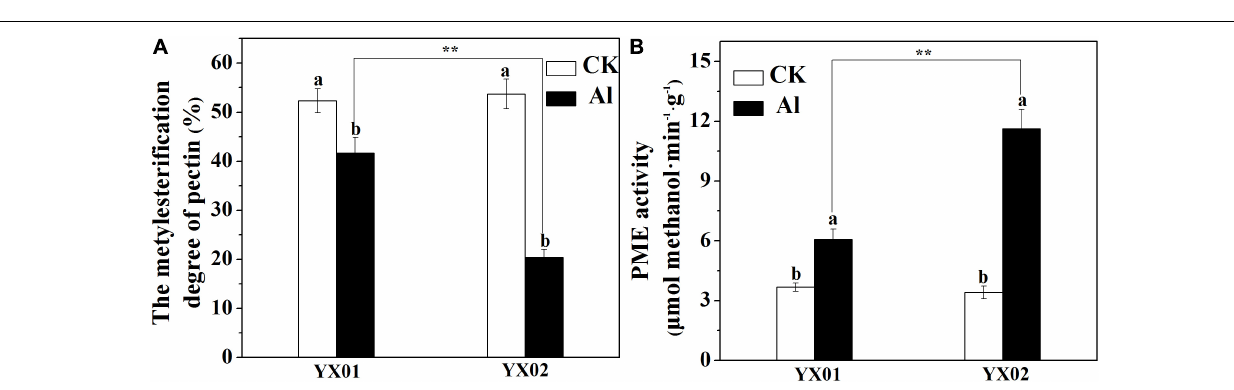
FIGURE 6 | Effects of Al treatment on the degree of pectin methylesterification (A) and pectin methylesterase (B) in root tips of Chinese fir seedlings. Two-month-old Chinese fir seedlings were exposed to 1/2 strength complete nutrition solution without Al (CK), or with 1 mM AlCl 3 (Al) for 16 d. After treatment, root tips of Chinese fir were collected for further analysis. Bars are means of four replicates ± SD. Different letters above histogram represent significant differences at P < 0.05 . ** above lines represent significant differences between genotypes at P < 0.0 1,